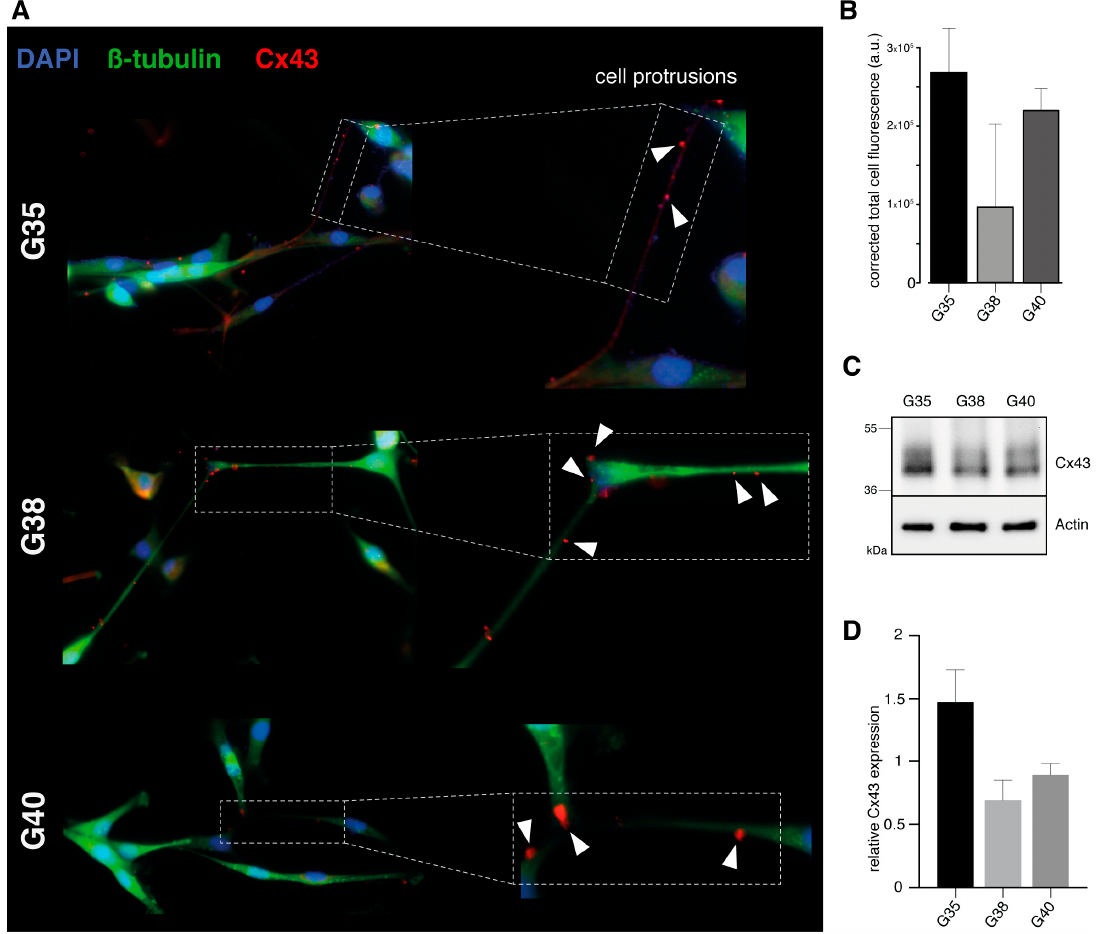
Figure 1. Verification of connexin-43 expression in primary glioblastoma cell populations. ( A ) Immunofluorescence staining: differentiated glioblastoma cells (G35, G38, and G40) were stained for Cx43 (red), ß-tubulin (green), and DAPI (blue). One representative image for each primary glioblastoma cell population is shown. White arrowheads point at positive Cx43 staining detected along characteristic ultra-long and lathy cell protrusions. Magnification: 40×. ( B ) Quantification of Cx43 protein expression: The relative expression level of Cx43 is shown as corrected total cell fluorescence. Mean ± SD of three measurements is depicted. ( C , D ) Western blot analysis and densitometric quantification of Cx43 protein expression: Actin was used as loading control. Mean ± SD of two measurements is shown. All three cell populations are positive for Cx43. G, glioblastoma; and Cx43, connexin-43.